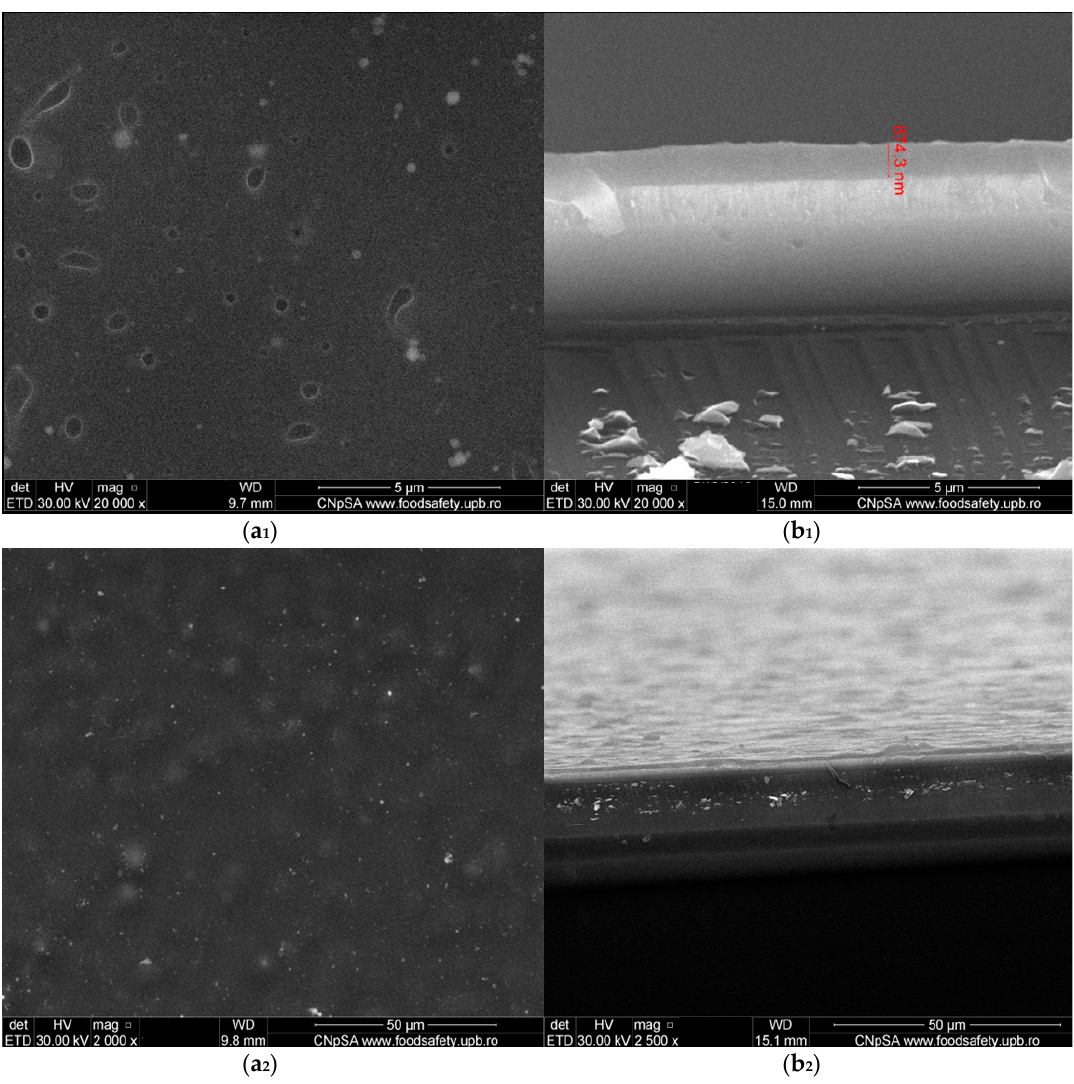
Figure 7. Plain view of the obtained MAPLE surface at different magnifications, ( a 1 ,a 2 ), and cross section of the thin film revealing average thickness and ( b 1 ,b 2 ) obtained through SEM analysis (at 20,000 magnification ) of PLGA/Fe 3 O 4 @CEF coating obtained at 400 mJ/cm 2 laser fluence.